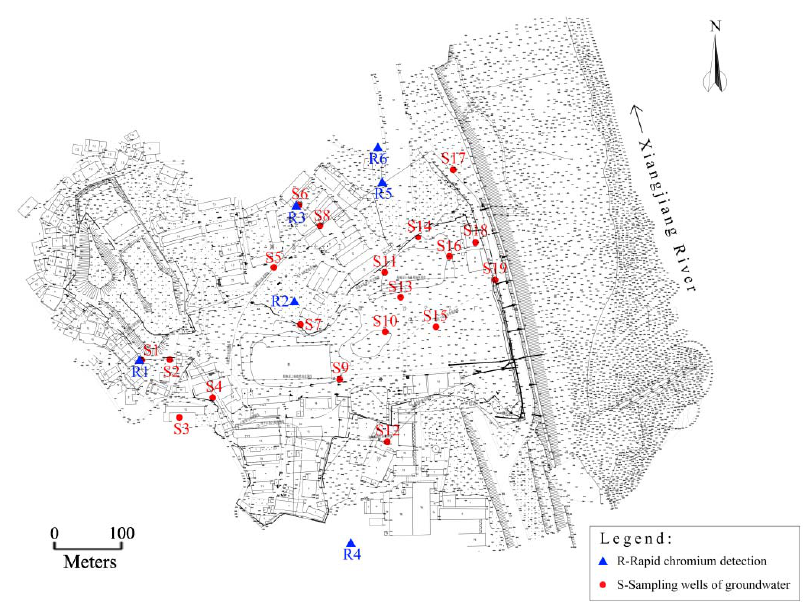
Figure 1. Map of groundwater sampling sites in the brownfield.